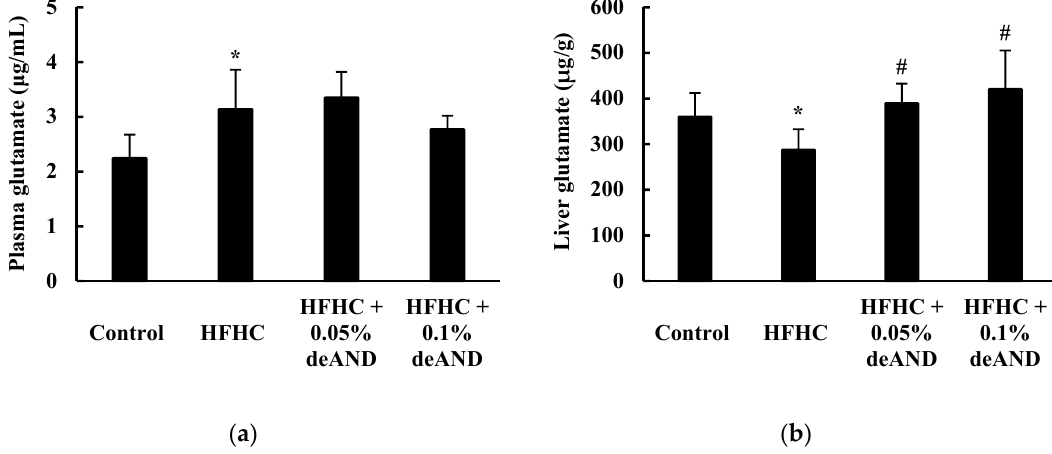
Figure 7. Effects of deAND supplementation on glutamate levels in the plasma ( a ) and liver ( b ) in mice. Results are expressed as the mean ± S.D. ( n = 6). * Significantly different from the Control group, p < 0.05. # Significantly different from the HFHC group, p < 0.05.